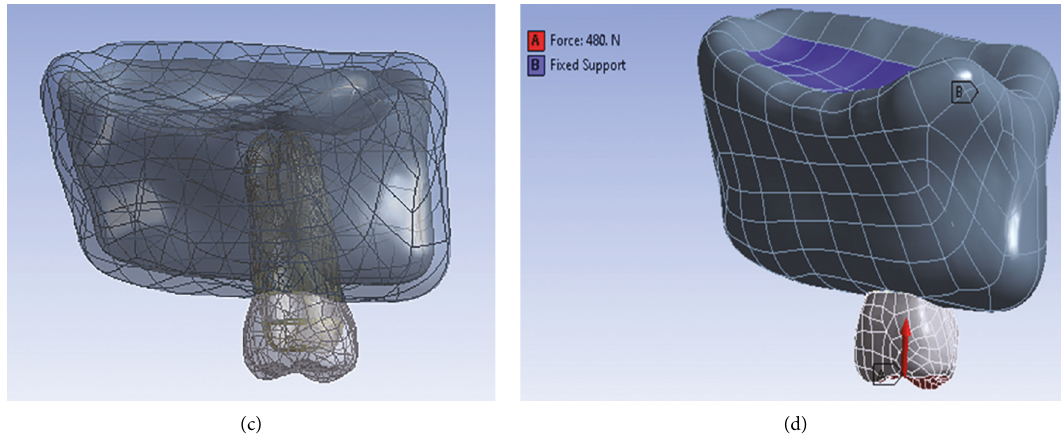
Figure 1: (a) Maxillary right first molar (grid � 1 sq. · mm) CT scan images. (b) Model in STL format. (c) Model in STP format. (d) Application of vertical and oblique